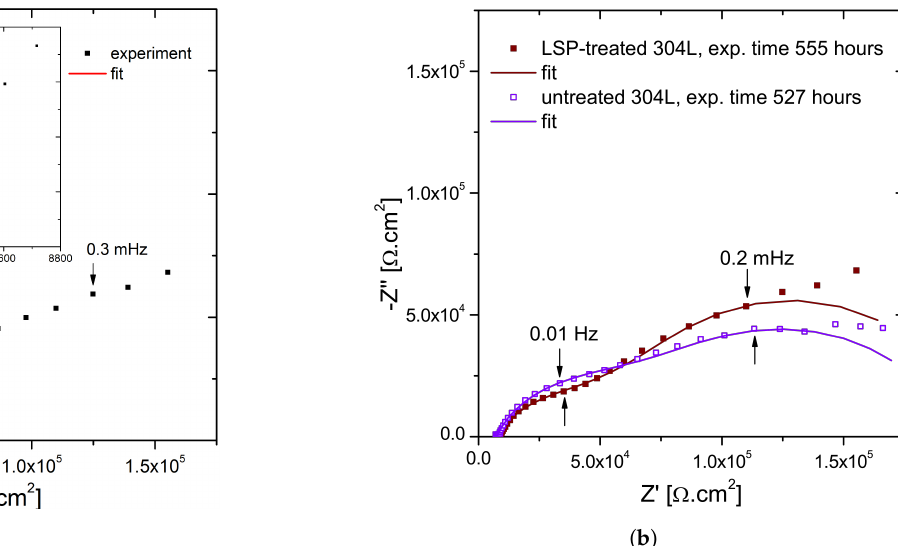
Figure 7. ( a ) Manual evaluation of the high-frequency part of the spectrum, representing the response of the oxide layer, is shown in detail. ( b ) Impedance spectra in Nyquist diagram of LSP-treated sample exposed for 555 h and untreated sample exposed for 527 h.